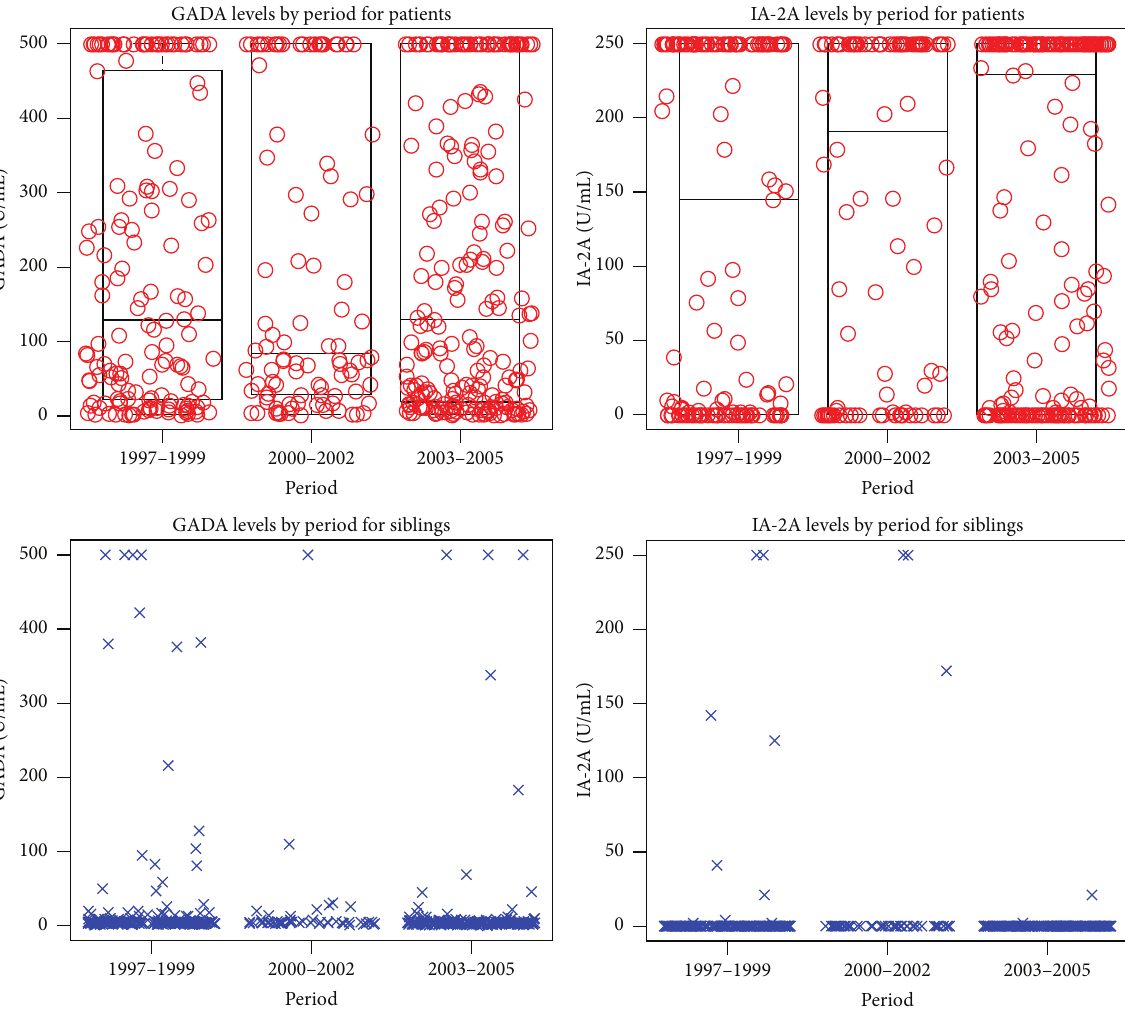
Figure 1: Combined box and scatter plots for GADA and IA-2A levels by period and stratification by patient status. Schematic box plots are only used in the patient stratum, due to no visual graphical gain when used in the sibling stratum, due to low levels of the two